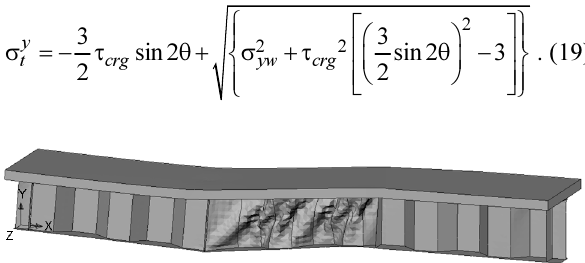
Fig. 8. Global buckling in a panel of a plate girder with corruga- ted webs